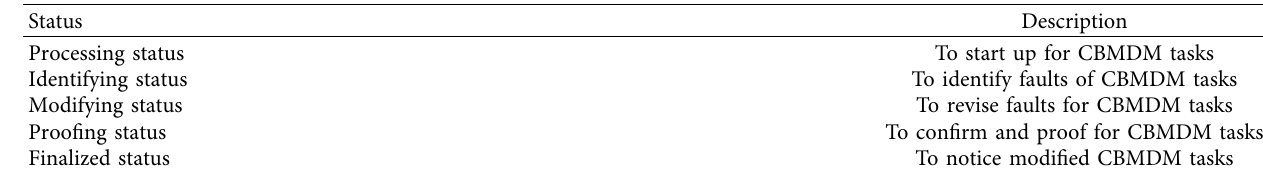
Table 1: The description of each status for the CBMDM procedures.